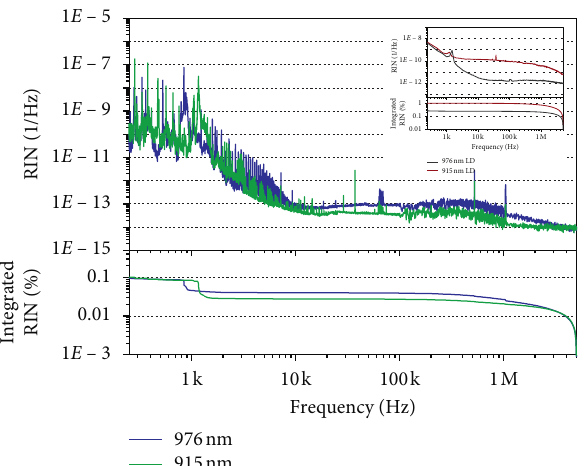
Figure 3: Amplifier RIN spectrums measured at pump wavelengths of 976nm (blue solid curves) and 915nm (green solid curves). Inset: measured RIN spectrums of the 976 nm LD (gray solid curve) and the 915 nm LD (red solid